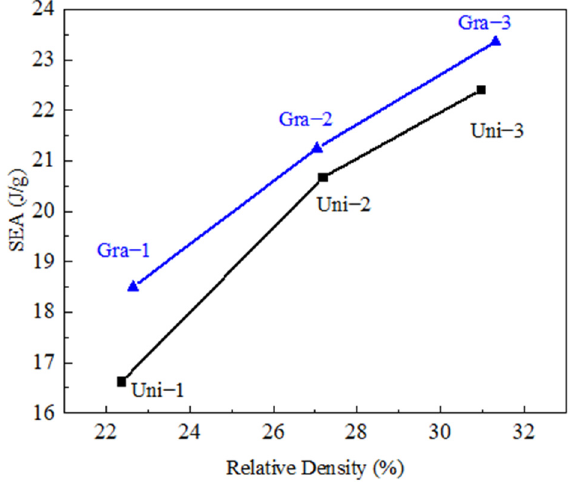
Figure 6. SEA comparison of the uniform and gradient TPMS structures with similar relative den- sities.